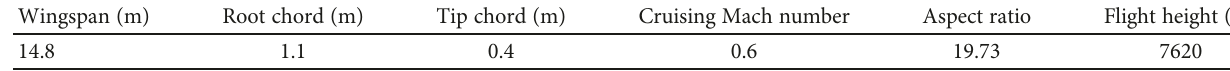
Table 1: Design parameters of the wing employed in the current study.